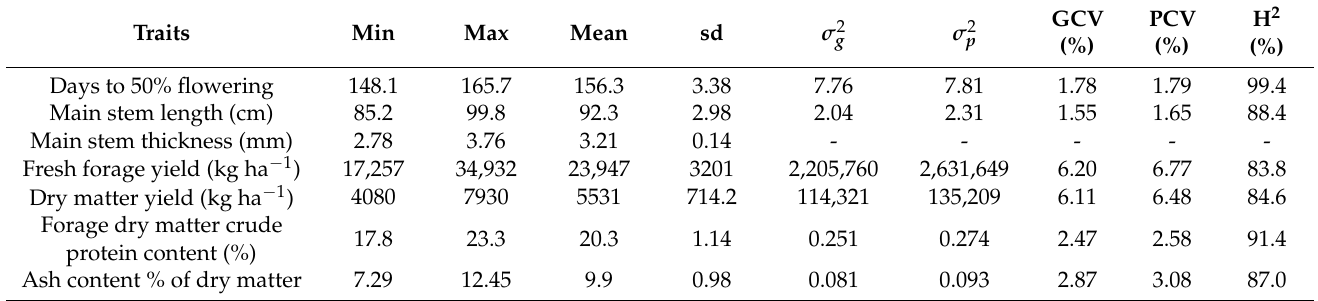
Table 5. Estimations of genetic parameters for tested traits: days to 50% flowering, main stem length (cm), main stem thickness (mm), fresh forage yield (kg ha − 1 ), dry matter yield (kg ha − 1 ), forage dry matter crude protein content (%), and ash content % of dry